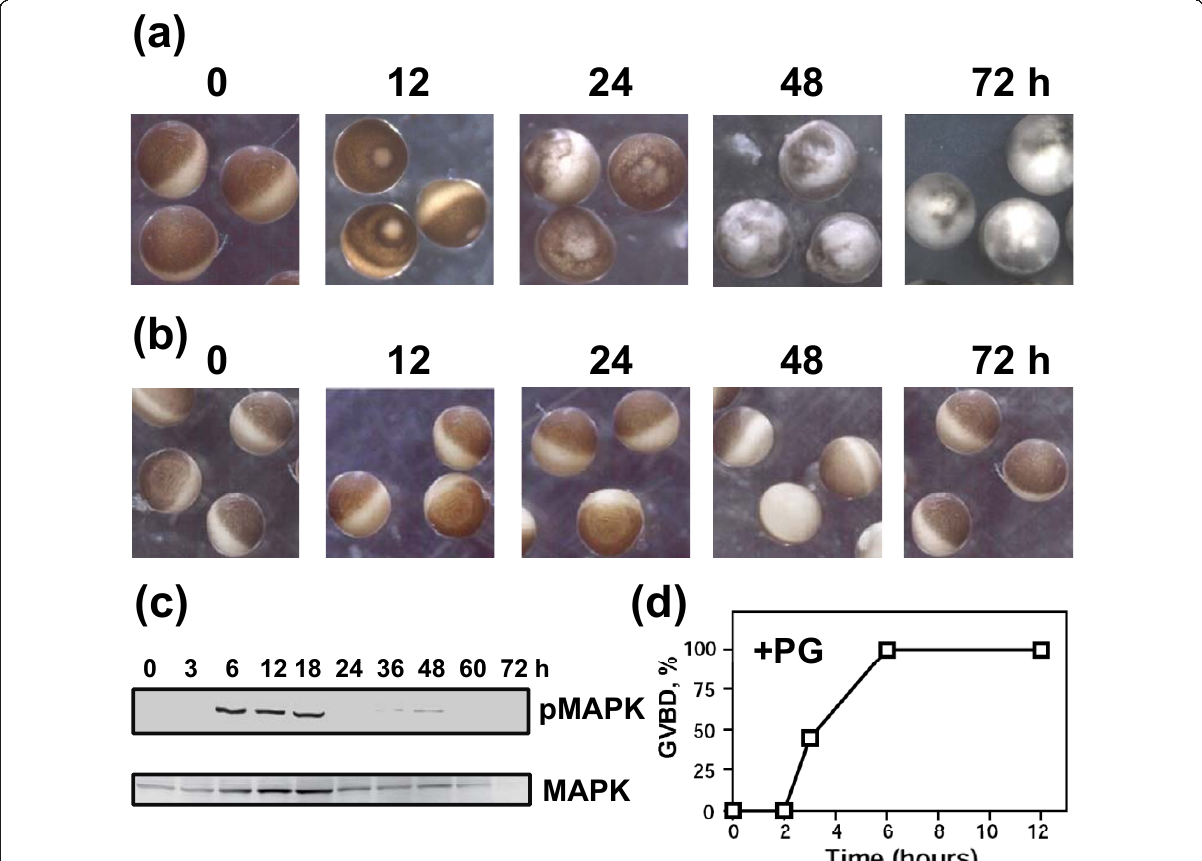
Figure 6 Stability of progesterone-treated and intact Xenopus oocytes . Defollliculated OR-2 buffer-deposited oocytes were treated with 10 μ M progesterone or left untreated and monitored over 72 hours. Morphology of the progesterone-treated (a) and -untreated (b) oocytes, MAPK phosphorylation state (c) , and time course of GVBD (d) after progesterone